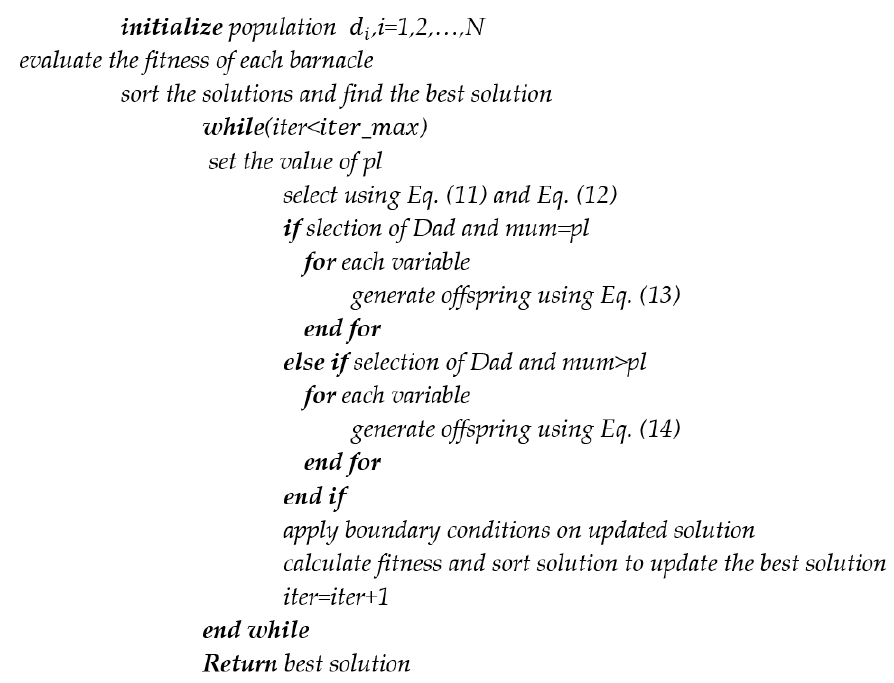
Figure 6. Pseudo code of BMO for TEG MPPT controller design.